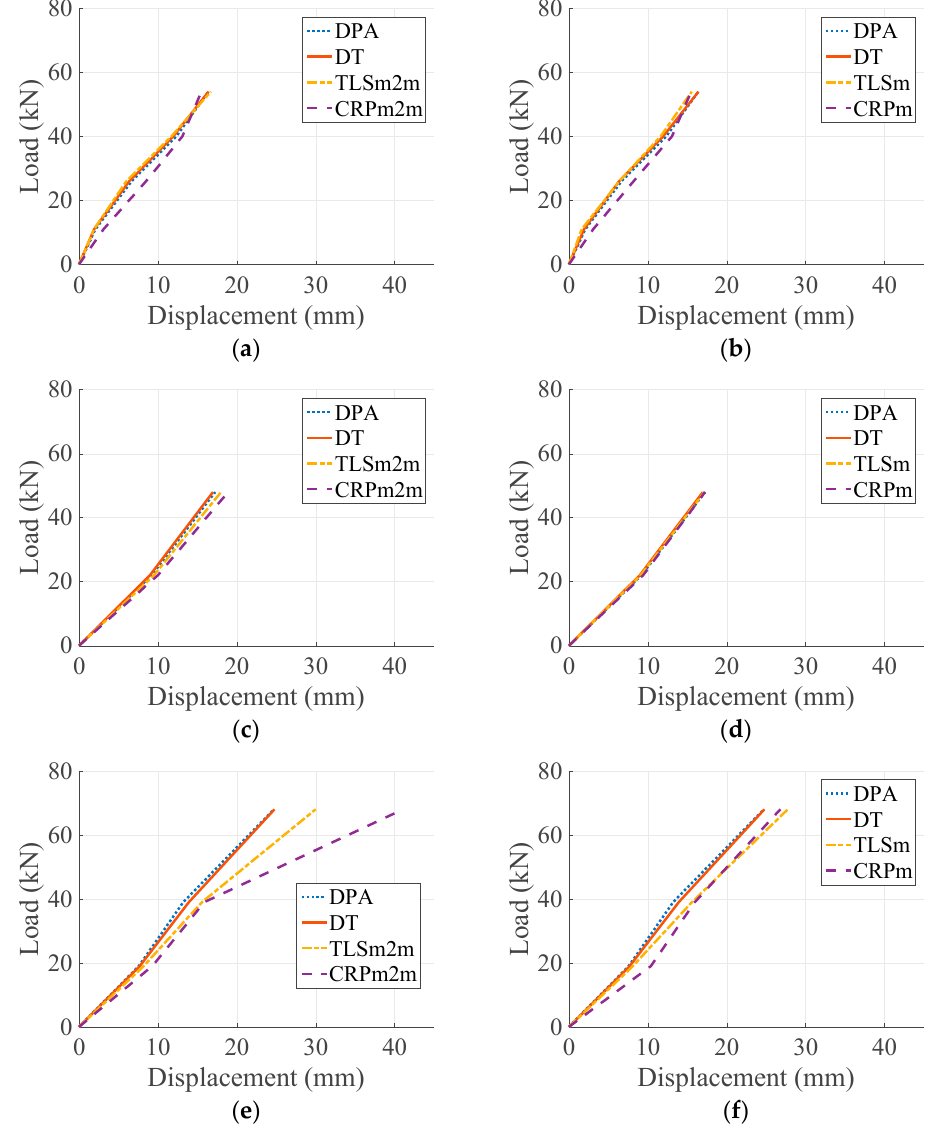
Figure 14. TLS and CRP midspan displacements comparison for beam#1 and #2. ( a ) beam#1 LC1 m2m comparison; ( b ) beam#1 LC1 m comparison; ( c ) beam#1 LC2 m2m comparison; ( d ) beam#1 LC2 m comparison; ( e ) beam#2 m2m comparison; ( f ) beam#2 m comparison.